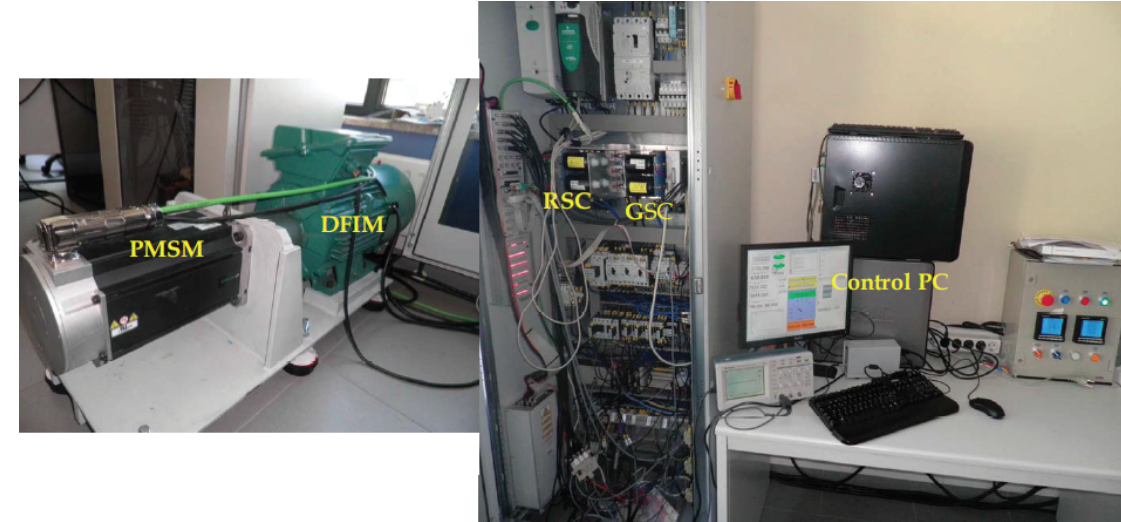
Figure 8. Picture of the experimental platform